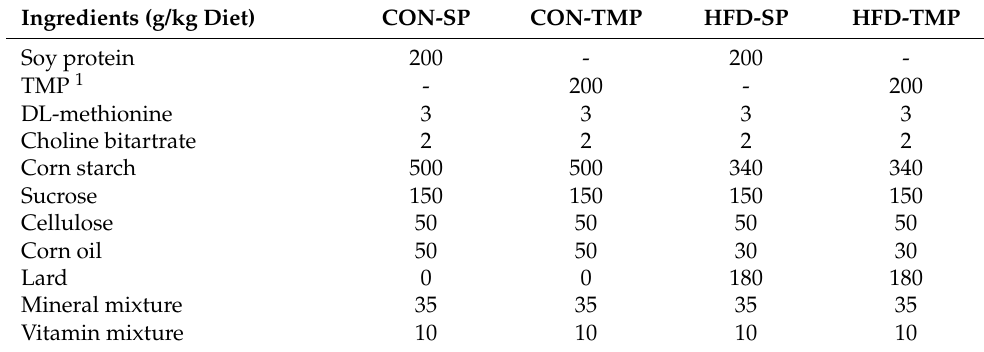
Table 4. Composition of experimental